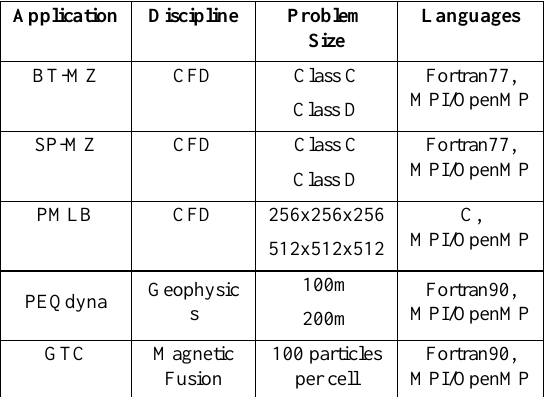
Table 1. Overview of Hybrid HPC